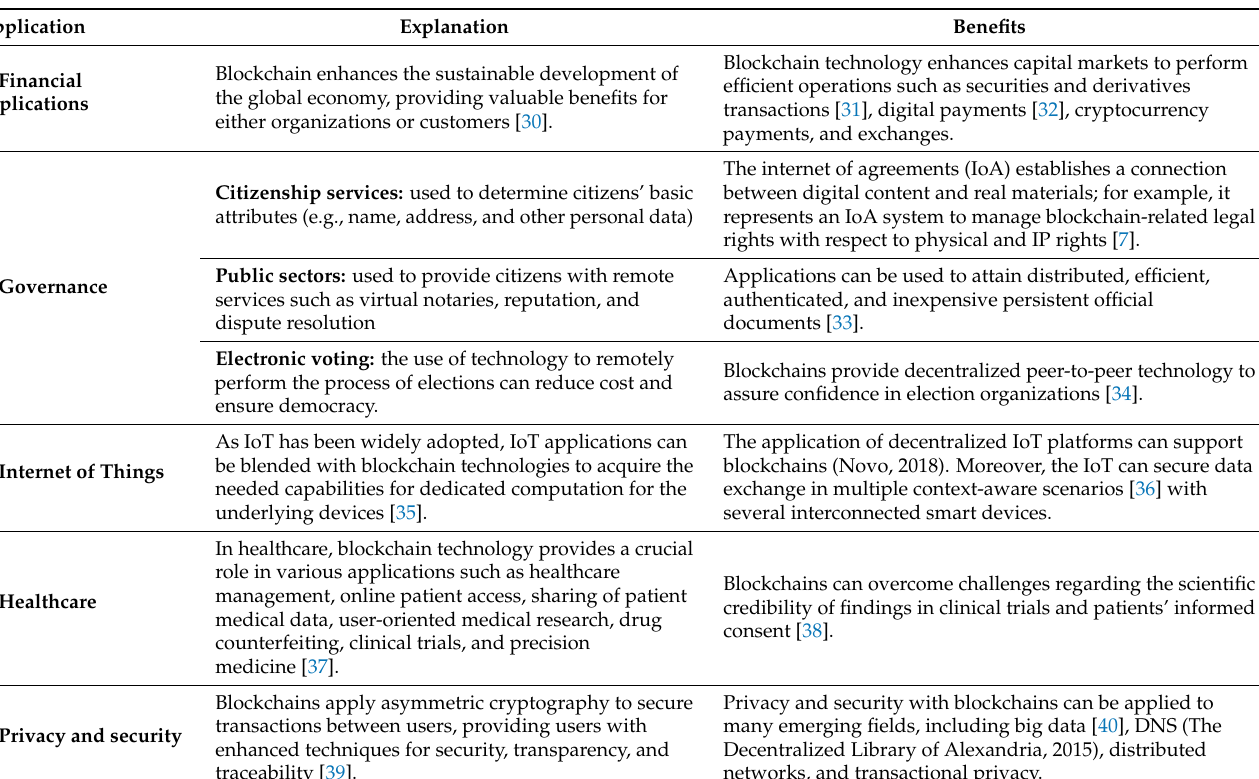
Table 1. Applications of blockchain according to various fields of